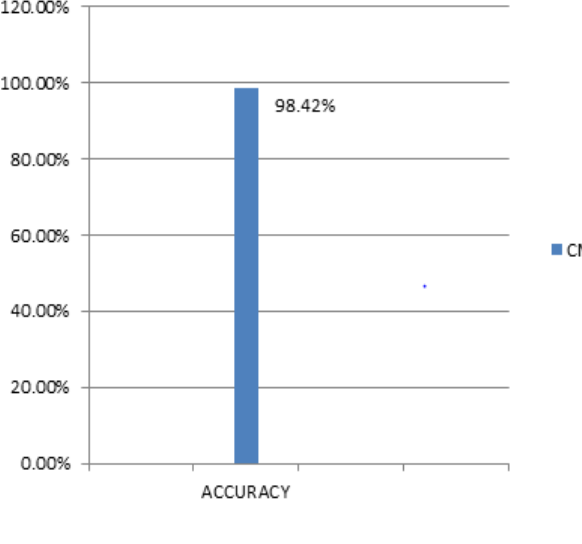
Fig.8. Accuracy comparison LR, CNN, LSTM